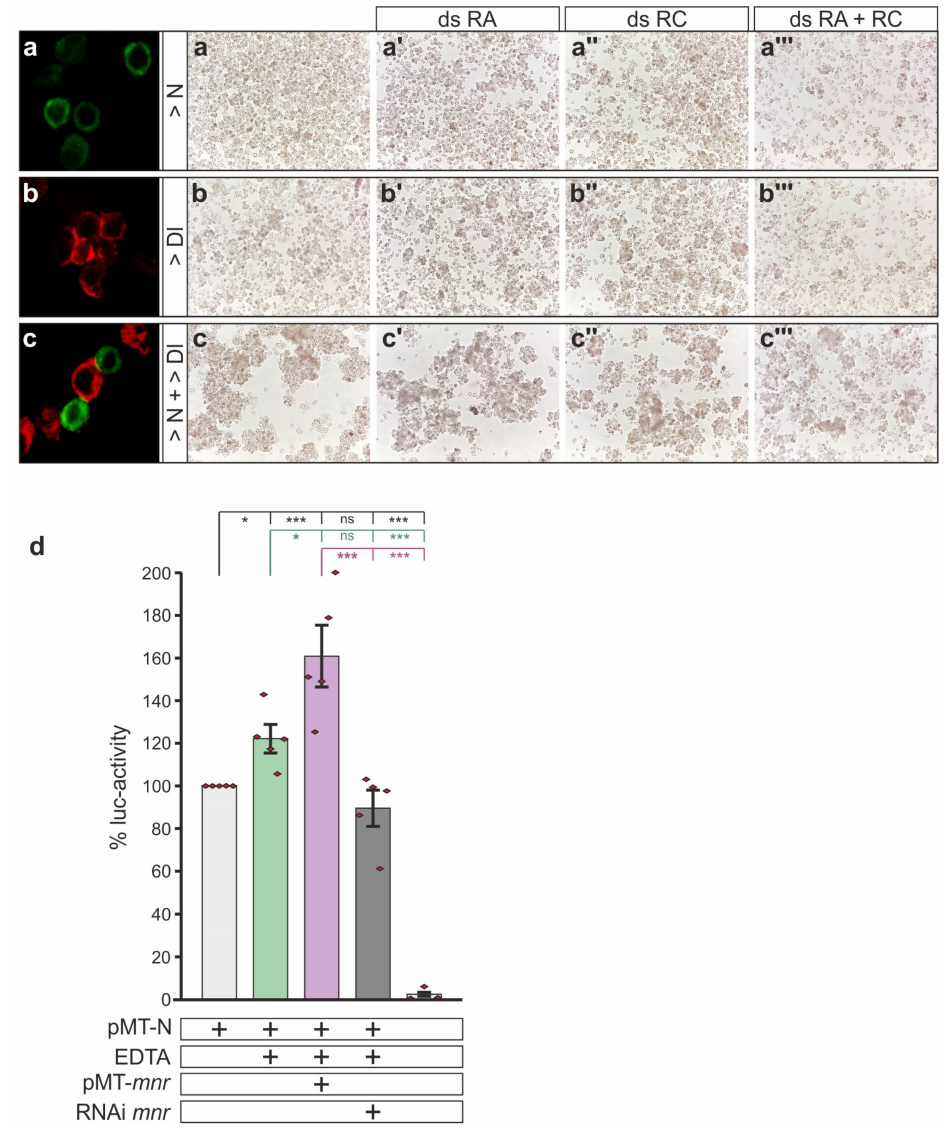
Figure 7. Mnr stimulates Notch receptor activation. ( a – c”’ ) Aggregation assay using S2 cells carrying either construct encoding full-length Notch ( a ), Delta ( b ), or both ( c ), plus double-stranded RNA of RA ( a’ , b’,c’ ), of RC ( a” , b” , c” ), or both ( a”’ , b”’ , c”’ ). The left panel shows confocal antibody staining against Notch (green) and Delta (red) to demonstrate membrane localization and homo- and heterotypic aggregation of the cells. The other pictures are bright field. There is no apparent influence of a knockdown of mnr activity on the aggregation of S2 cells. ( d ) Luciferase assay as a read out of Notch receptor activation. S2 cells were transfected with full-length Notch, and the receptor was activated by EDTA treatment as indicated, resulting in NRE-reporter activation. Co-transfection with mnr cDNA increased, and knockdown of mnr activity by RNAi against RA and RC decreased Notch signaling output. NRE activation is reported by luciferase (luc) activity, given in comparison to Notch-transfected cells without EDTA activation. Values are presented as mean ± SD from five experiments. Significance was assessed with ANOVA two-tailed Tukey–Kramer test for multiple comparisons; depicted relative to pMT-N (upper row), relative to pMT-N activated with EDTA (middle row, green) and relative to pMT-N activated with EDTA plus pMT-Mnr (lower row, lilac), as indicated (*** p < 0.001, * p < 0.05, ns not significant p >